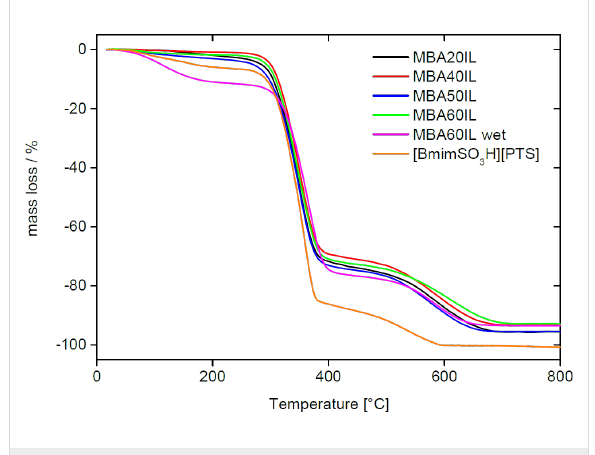
Figure 10: TGA data of MBA20IL, MBA40IL, MBA50IL, and MBA60IL along with TGA trace obtained from wet MBA60IL obtained